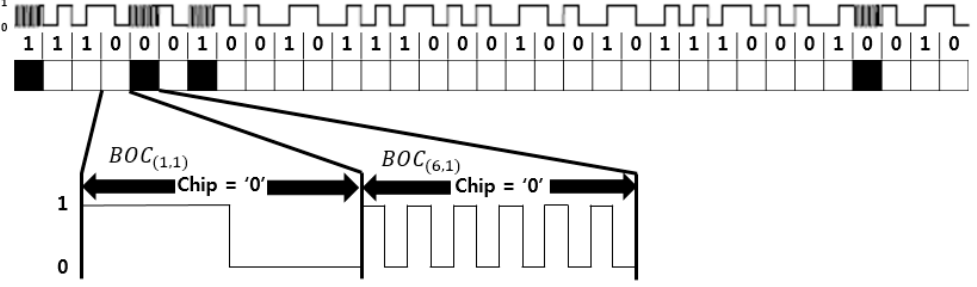
Figure 3. Structure of 𝑇𝑀𝐵𝑂𝐶